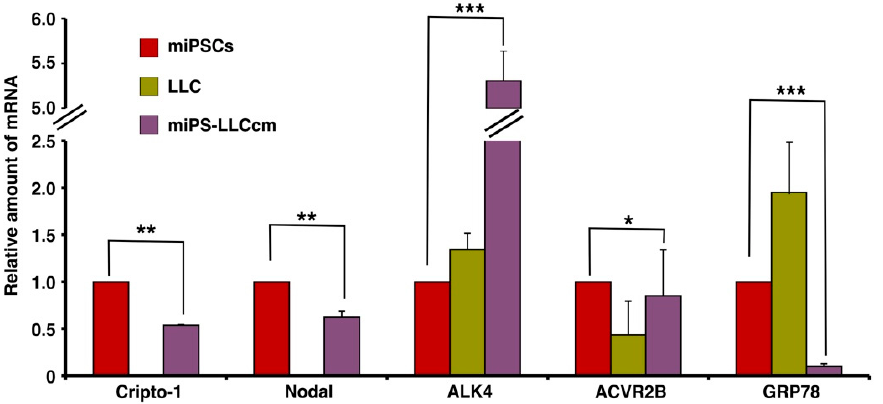
Figure 1. Expression of mRNA for Cr-1 and related molecules in miPSCs, Lewis Lung Carcinoma (LLC) and miPS-LLCcm cells. rt-qPCR was used to assess the relative expression of Cripto-1, Nodal, ACVR2B, ALK4 and GRP78 in these three cell lines. GAPDH was used as an endogenous control and each vertical bar represents the mean ± SD of three data points. The difference between the relative expression in miPS cells and miPS-LLCcm cells is statistically significant as evaluated by Student t -test (* p < 0.05, ** p < 0.01, *** p < 0.001).